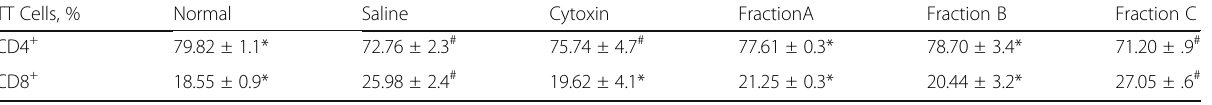
Table 3 Effect of Licorice polysaccharides on T lymphocyte population TT Cells,